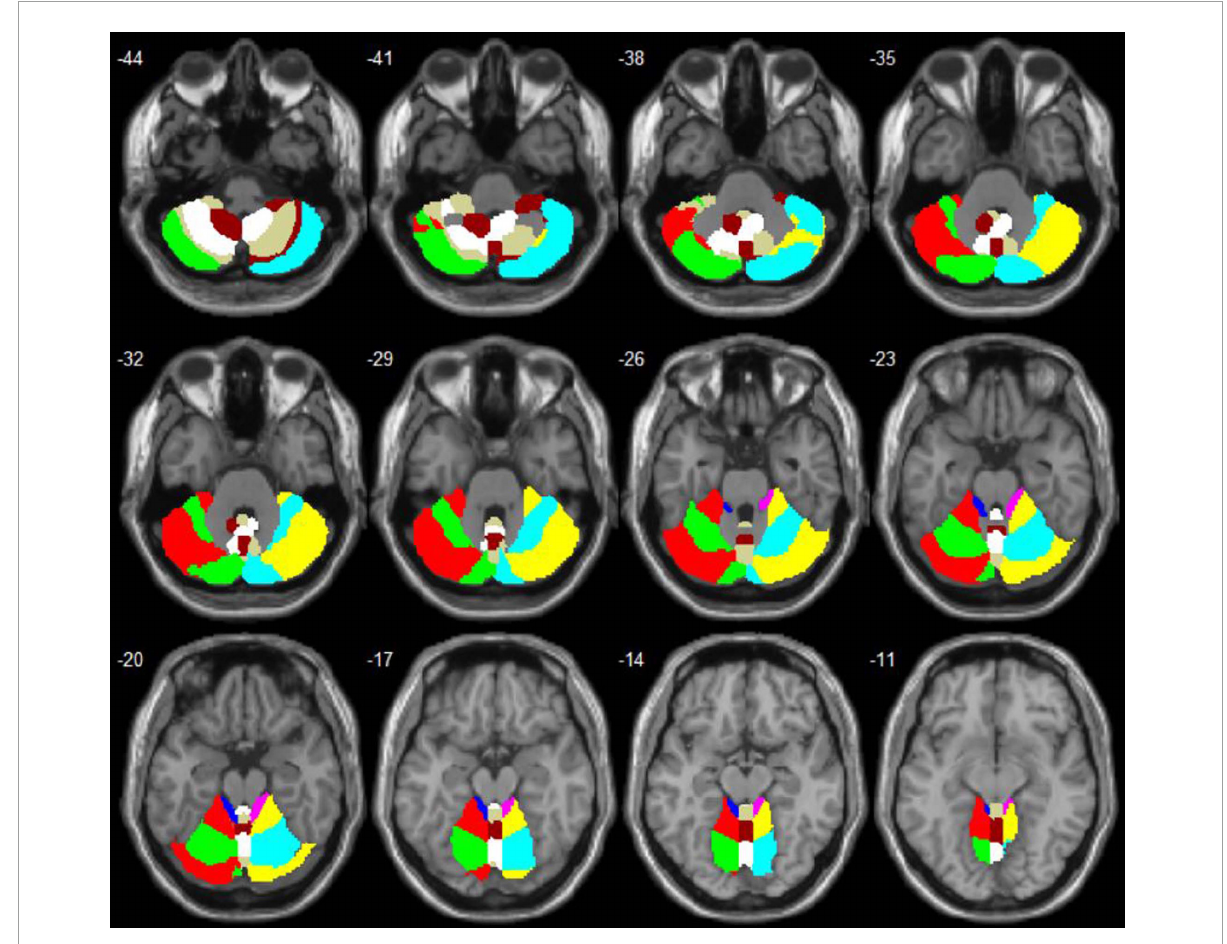
FIGURE1 Anatomical automatic labeling (AAL) maps of the cerebellum and vermis subregions.